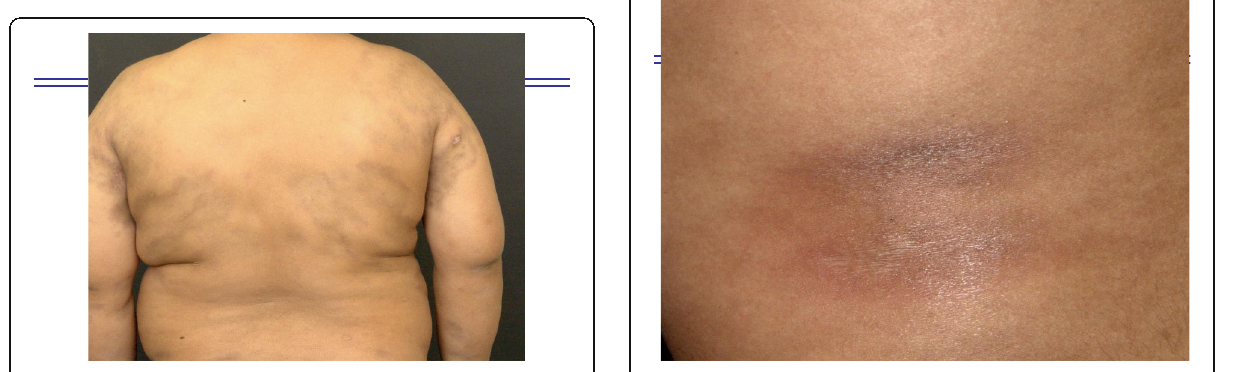
Fig. 2 Detail of lupus panniculitis presenting subcutaneous nodules with cutaneous atrophic and hyperpigmentated